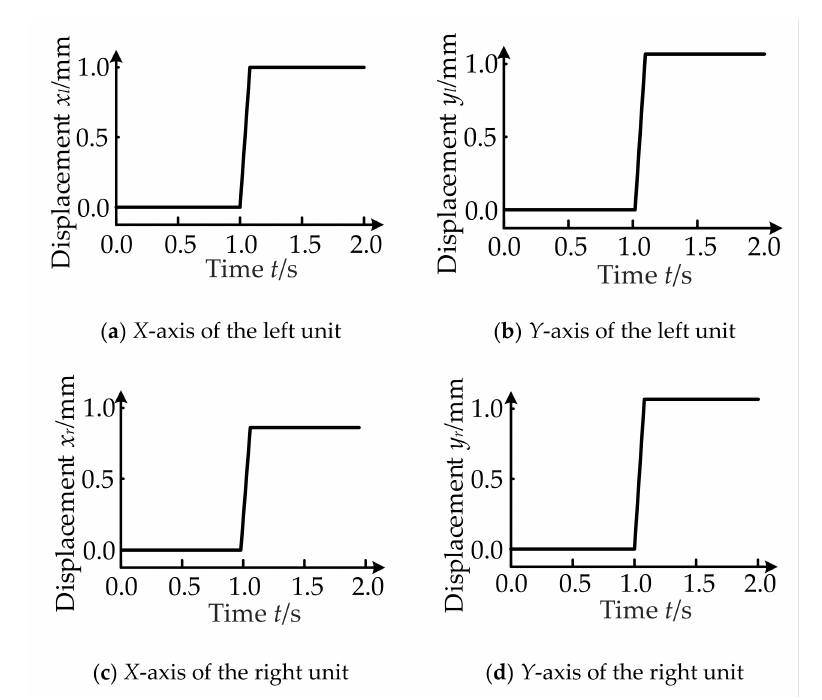
Figure 11. Displacement of the rotor under a step